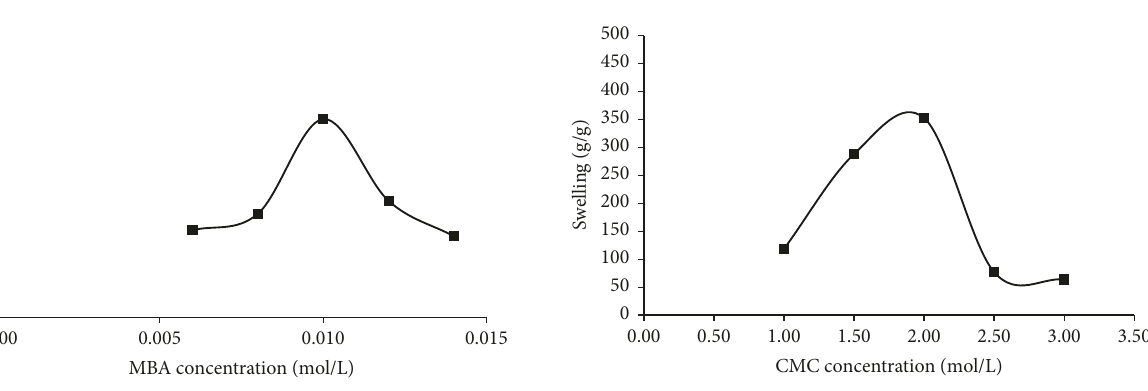
Figure 7: Effect of sodium carboxymethyl cellulose (NaCMC) on swelling capacity (reaction condition: 1.0mol/L AA, 70% neutral- ized AA, 0.01 mol/L MBA, and 0.014 mol/L KPS at 70 ∘ C for 90min).